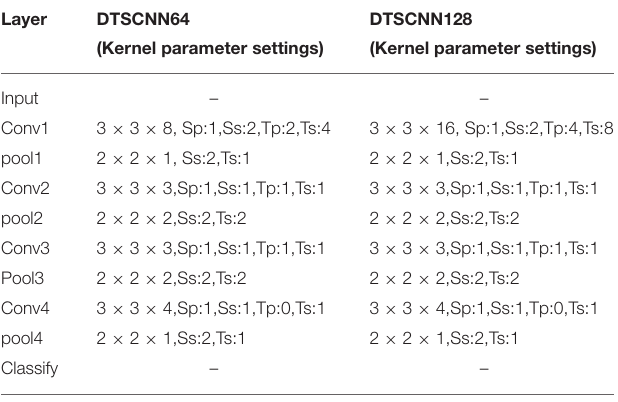
Frontiers in Psychology |